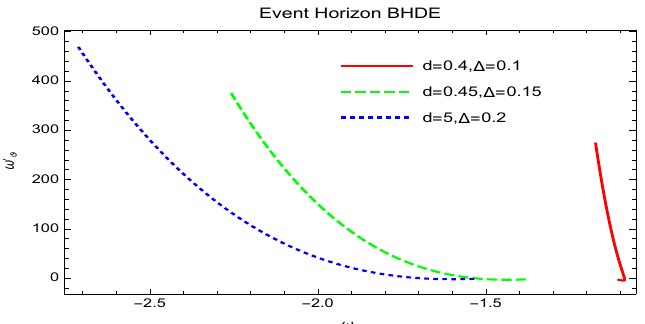
Figure 10. Plot of ω ϑ versus ω (cid:48) for interaction BHDE model with event horizon in the framework of ϑ GDP braneworld cosmology.